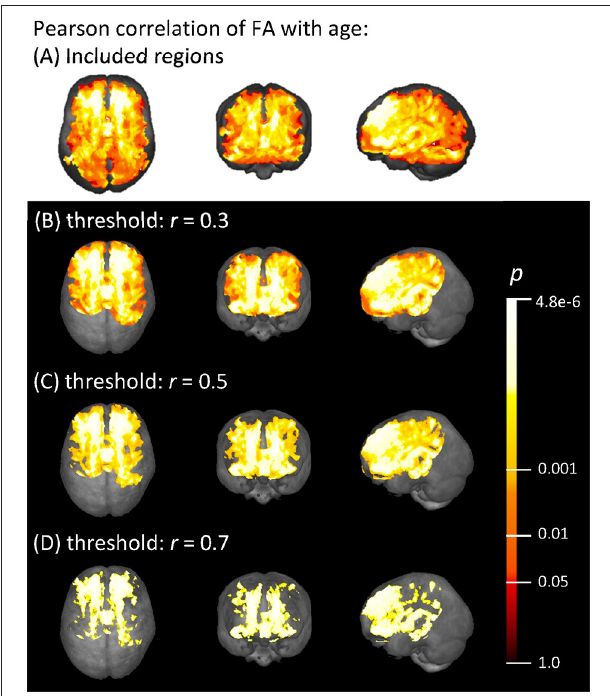
FIGURE 3 | (A) Voxels with an FA > 0.2 that were included in the correlation analysis, and (B–D) voxel-wise Pearson correlation of FA with age (range 19.5–81.9 years) shown in axial, coronal, and sagittal projectional views, respectively. Correlation coefficient r is given above a threshold of (B) r = 0.3, (C) r = 0.5, and (D) r = 0.7, corresponding to increasing strength of the correlation. The color bar represents the p